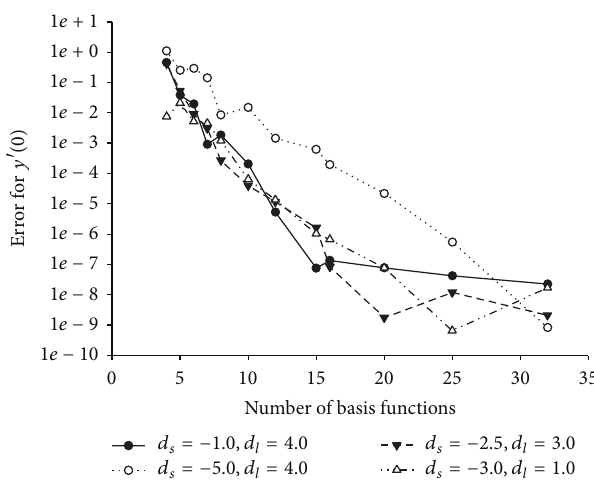
Figure 4: Convergence rate of the initial slope 𝑦 󸀠 (0) of the Thomas- Fermi equation calculated using different parameters for defining the exponential basis set. In all the tests the exponent had the value 𝑠 = 5